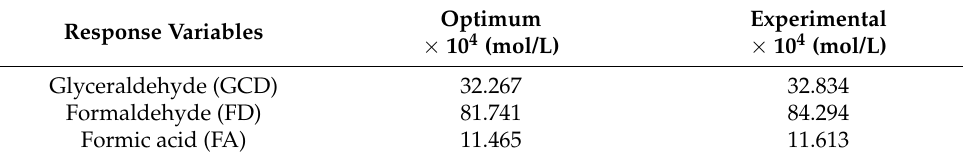
Table 5. Optimum and experimental values of the response variables.